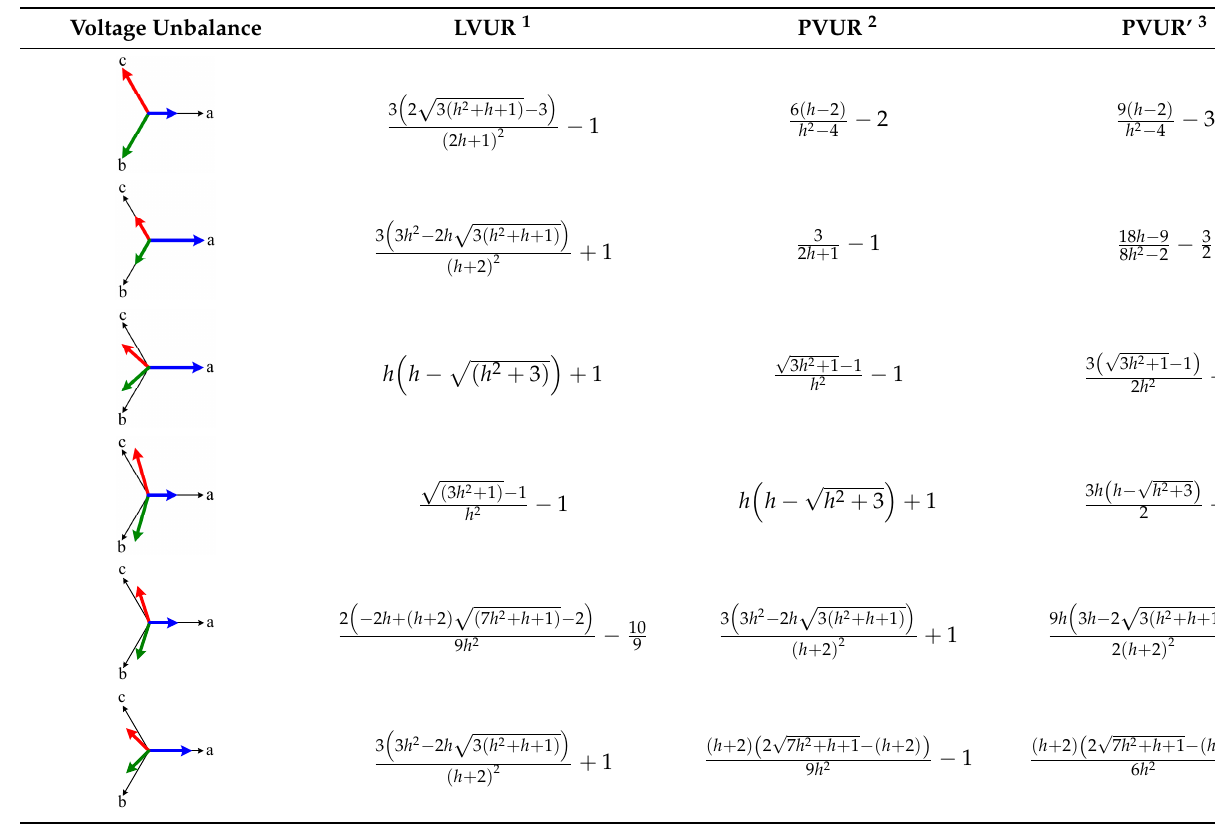
Table 2. Voltage unbalance quantification by using phase-to-phase (line) voltages or phase-to-neutral